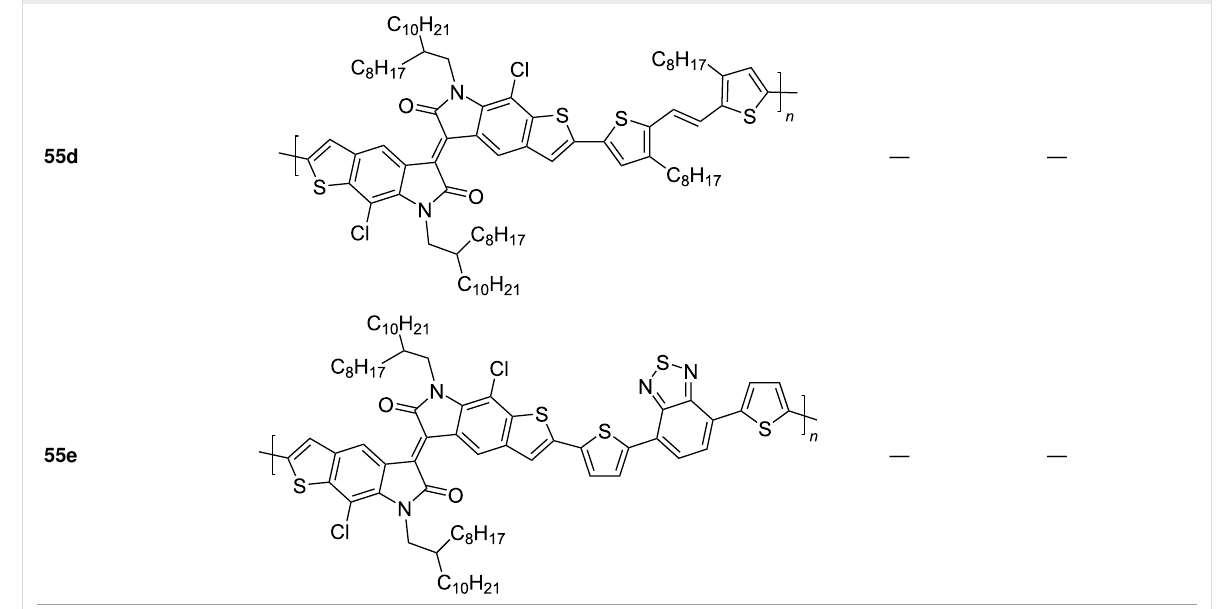
Table 8: Transistor characteristics of homopolymers 53 – 55 . a (continued)